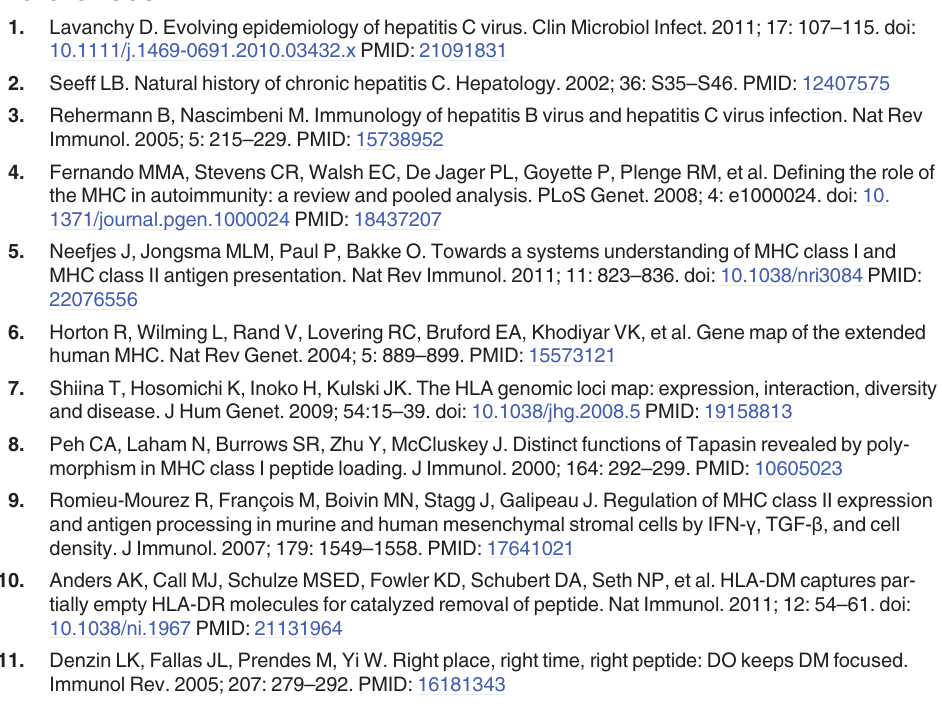
S2 Table. Comparison results of SNPs distribution in dominant, recessive, and additive models. All SNPs were searched for concrete location in genes. Each model was used to find the different distribution of SNPs in HCV resolvers versus HCV chronic cases and HCV chronic cases versus HCV resolvers. S3 Table. Stratified analysis in subgroups. Rs1800454, rs2071469, rs9277972 and rs3128935 used stratified analysis in dominant and additive models by population